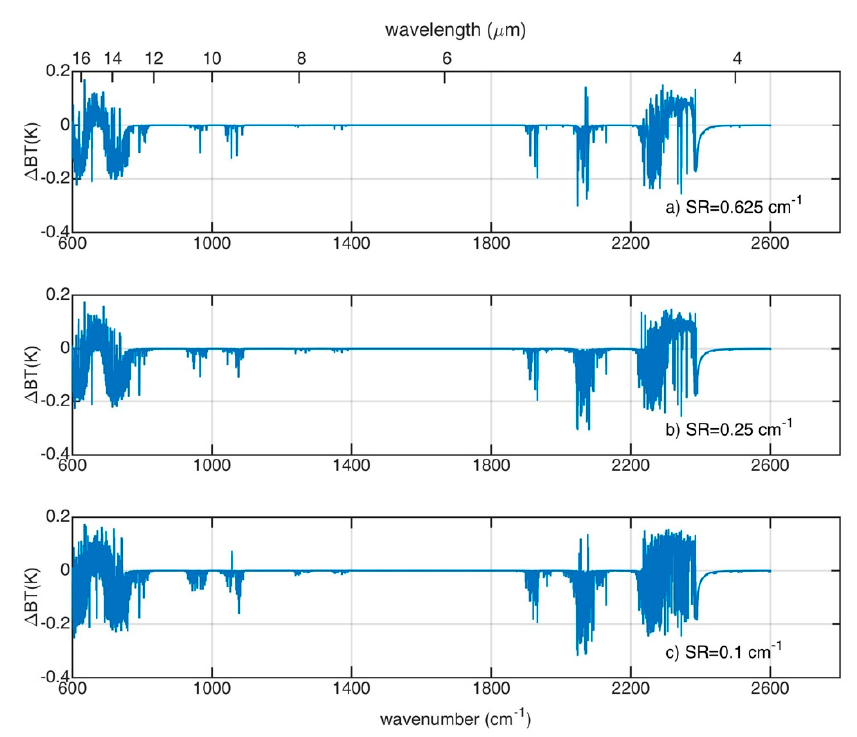
Figure 4. BTD when CO 2 concentration profile has an increment of 5 ppmv with regard to spectra with ( a ) 0.625, ( b ) 0.25 and ( c ) 0.1 cm − 1 spectral resolution, respectively.